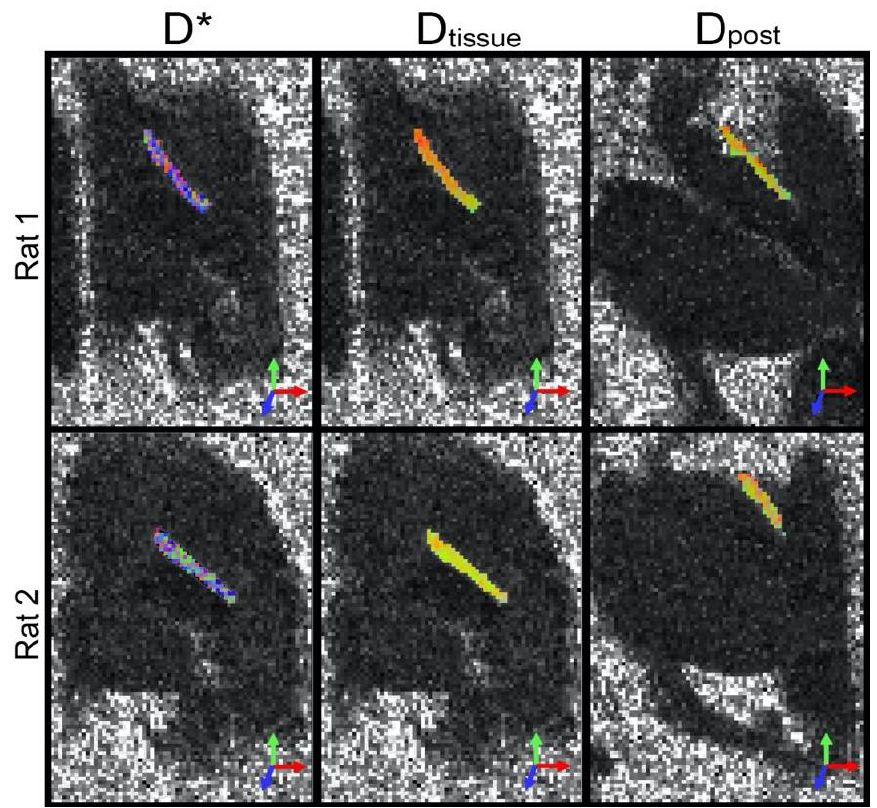
Figure 3. Diffusion orientations of the rat sciatic nerve. The primary eigenvectors of D * (i.e., fast compartment of the in vivo diffusion signal), D tissue (slow compartment of the same), and D post (post-mortem diffusion signal) from two animals (separate rows) are RGB-coded, shown overlaid on their FA maps. The intensities of the images have been scaled to enhance contrast.